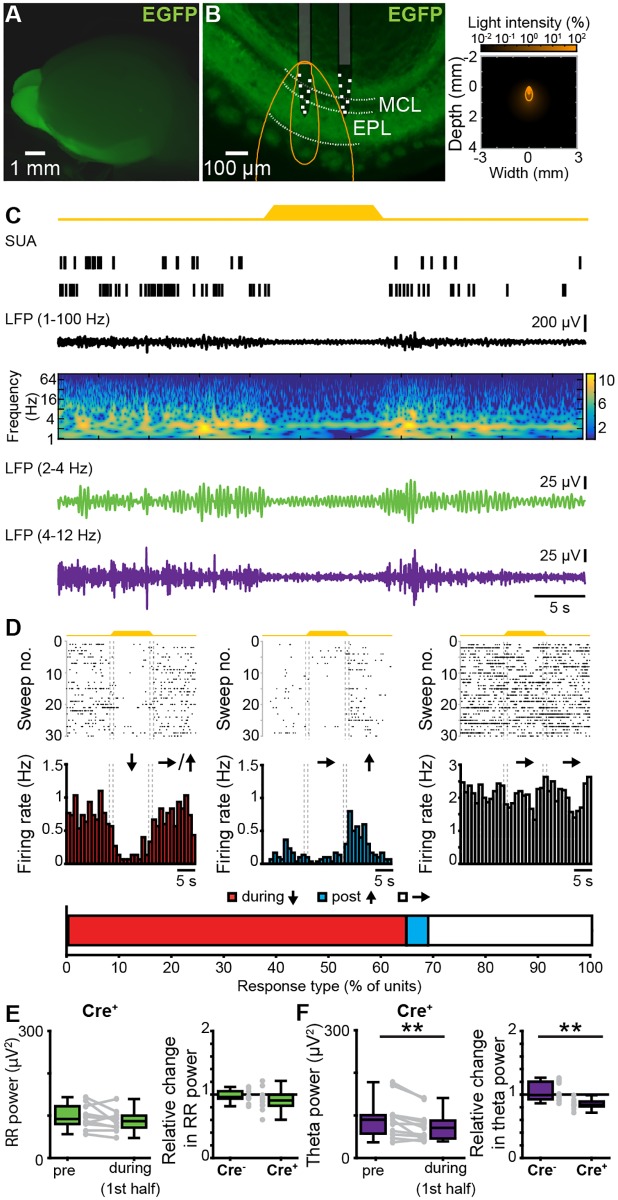
Effects of optogenetic silencing of MTCs on the patterns of oscillatory activity in the neonatal OB.(A) Photograph of the brain of a P8 cre+ Tbet-cre;ArchT-EGFP mouse (left) showing EGFP-fluorescent MTCs cell bodies and their projections. (B) Left, photograph of a 100 μm–thick coronal section including the OB from a P8 cre+ Tbet-cre;ArchT-EGFP mouse. The position of recording sites in MCL and EPL layers is marked by white squares. The light guide ending just above the recording sites is shown in gray. The iso-contour lines of light spreading calculated using Monte Carlo simulation are shown in yellow. Right, propagation of light intensity in the brain as predicted by Monte Carlo simulation. Yellow lines correspond to the iso-contour lines for light power of 1 and 10 mW/mm2, respectively. (C) Neuronal firing (SUA) and LFP band-pass filtered for different frequency bands (broad 1–100 Hz, RR 2–4 Hz, theta 4–12 Hz) in response to light (yellow, 594 nm) stimulation of MTCs in a P8 cre+ Tbet-cre;ArchT-EGFP mouse. Traces are accompanied by the color-coded wavelet spectrogram of LFP shown at an identical timescale. (D) Raster plots and peristimulus time histograms displaying the firing of MTCs in response to light stimulation. The color-coded bar (bottom) displays the fraction of cells that responded with a firing decrease during stimulus (red), constant firing during stimulus but a firing increase post stimulus (blue), and unchanged firing rate (white). (E) Box plots displaying the absolute power before and during light stimulation in cre+ pups (left) and the relative change of RR activity in neonatal OB of cre+ and cre− mice (right). Gray dots and lines correspond to individual animals. (F) Same as E for discontinuous theta bursts (**p < 0.01, left: signed-rank test, right: rank-sum test). Data are available in S1 Data. EGFP, enhanced green fluorescent protein; EPL, external plexiform layer; LFP, local field potential; MCL, mitral cell layer; MTC, mitral and tufted cell; OB, olfactory bulb; P, postnatal day; RR, respiration-related rhythm; SUA, single-unit activity.